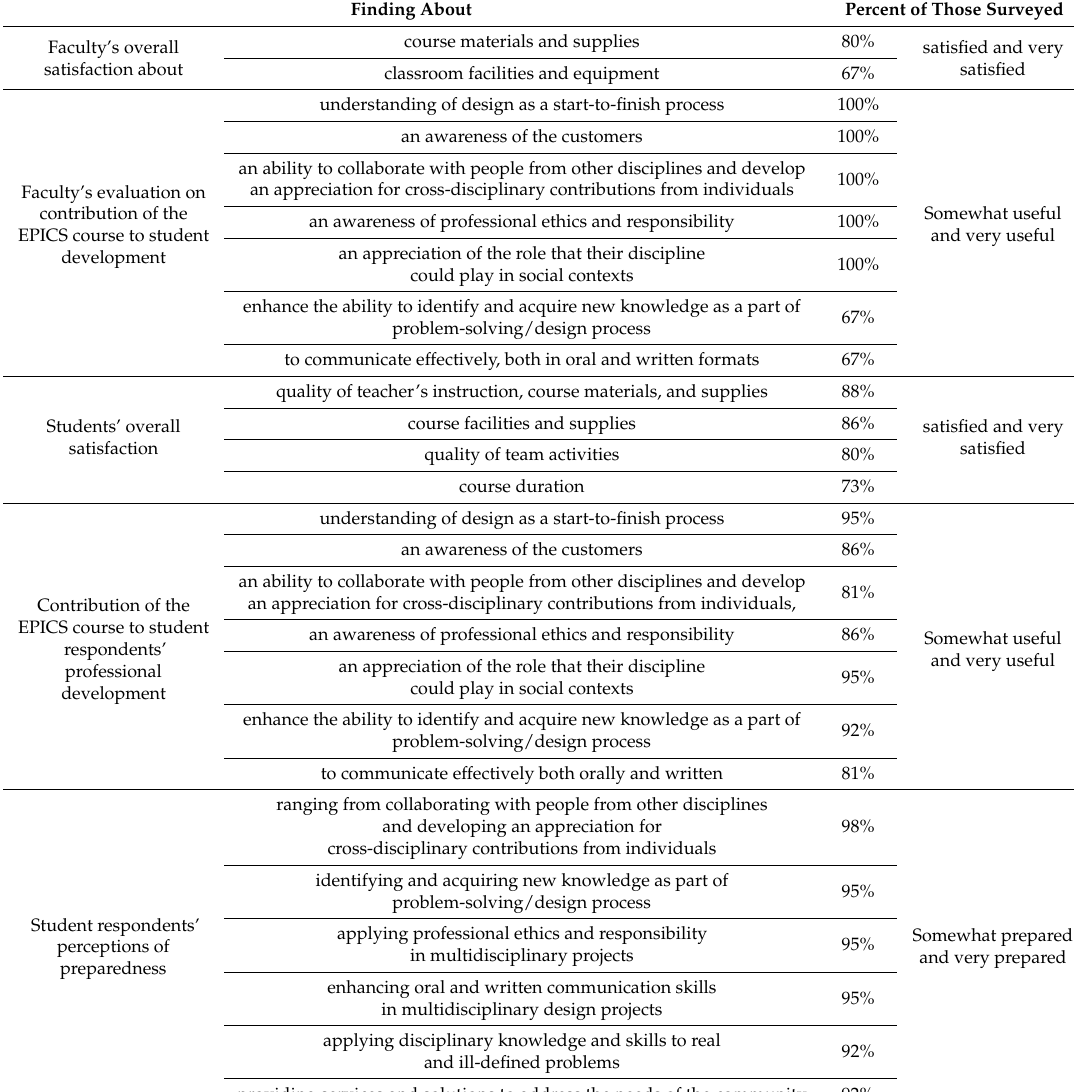
Table 5. Table of survey’s